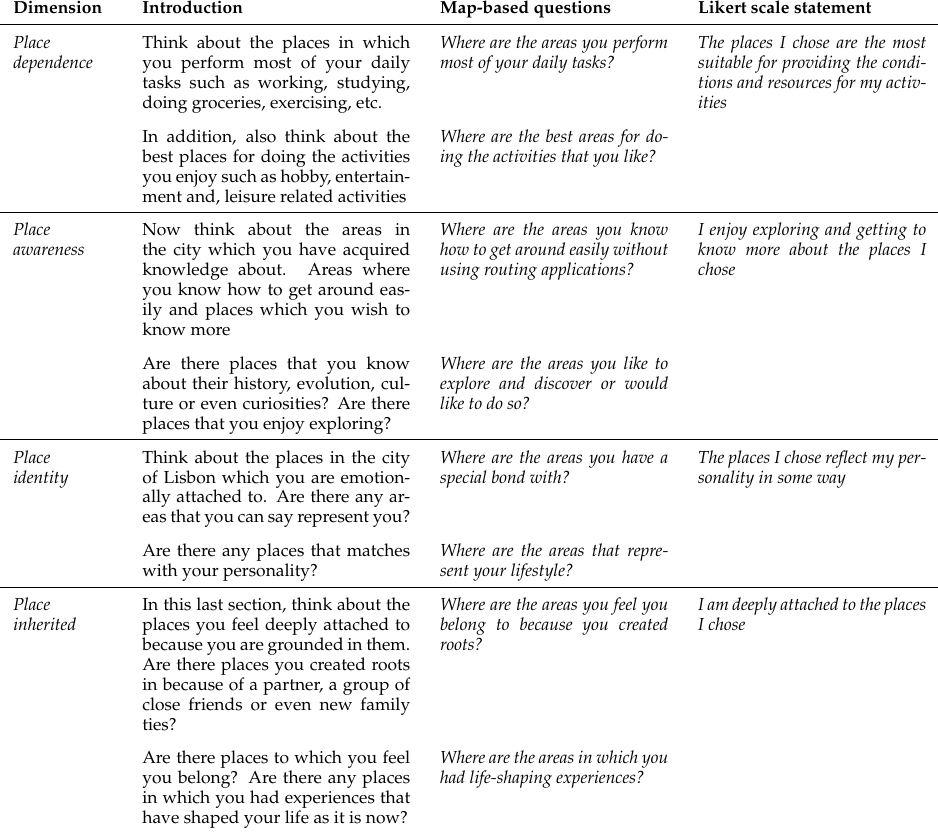
Table 2: Questions and introductions of each dimension of sense of place assessed in the